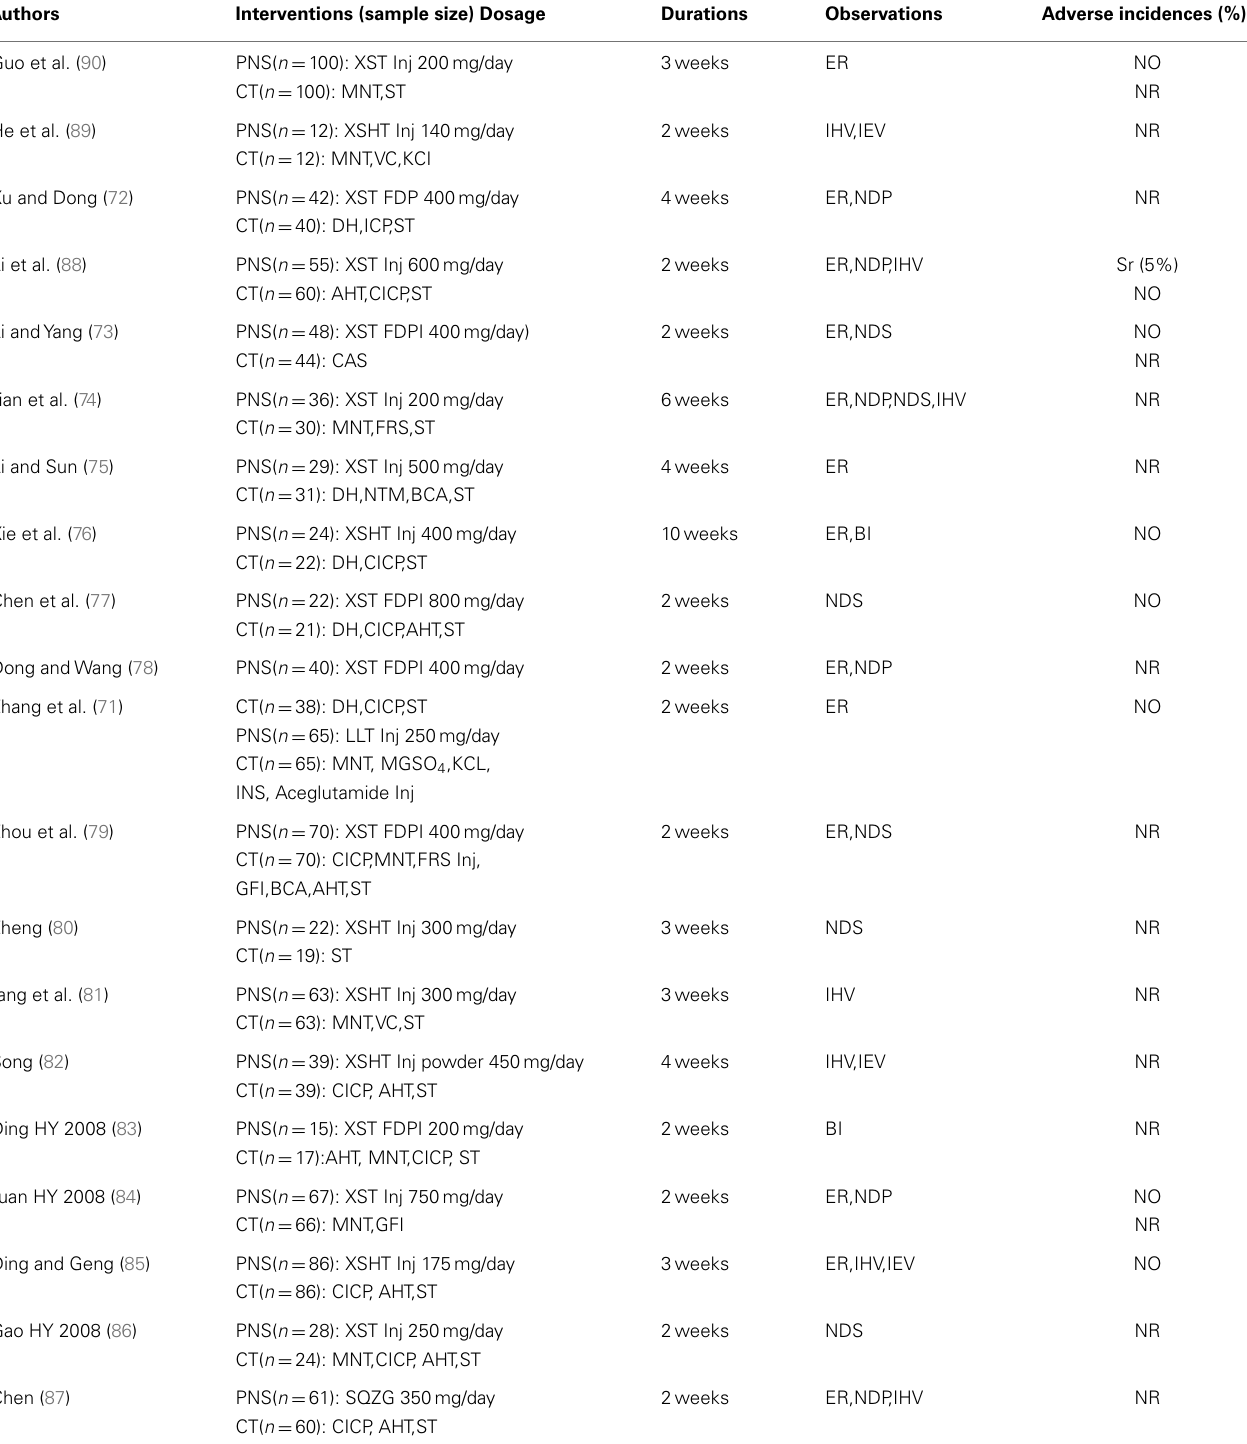
Table 2 | PNS treatment information of the 20 trials included in the meta-analyses